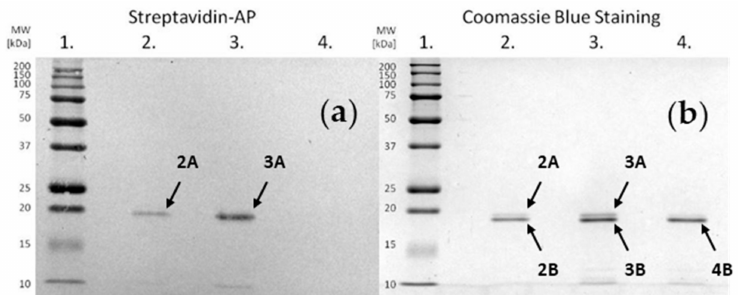
Figure 6. ( a ) Image of the membrane after the electroblotting. ( b ) Image of the gel obtained by sodium dodecyl sulphate polyacrylamide gel electrophoresis (SDS-PAGE) separation. Wells numbered 1–4 correspond to: 1.—MW standards; 2.—staphopain C incubated with biotinylated inhibitor at pH 5.0; 3.—staphopain C incubated with biotinylated inhibitor at pH 7.8; 4.—staphopain C. Bands labeled “A” correspond to staphopain C with a covalently attached inhibitor and bands labeled “B” correspond to native staphopain C.